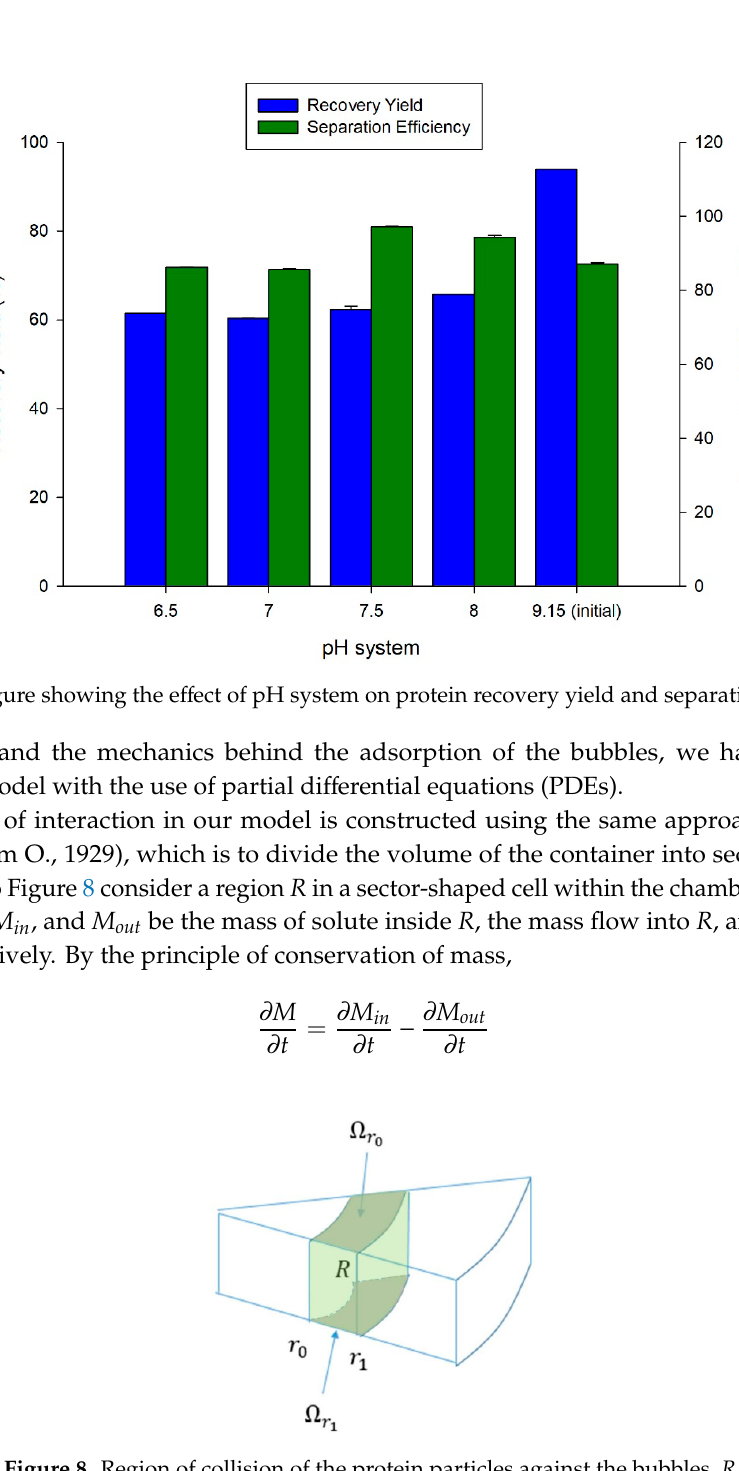
Figure 8. Region of collision of the protein particles against the bubbles, R .